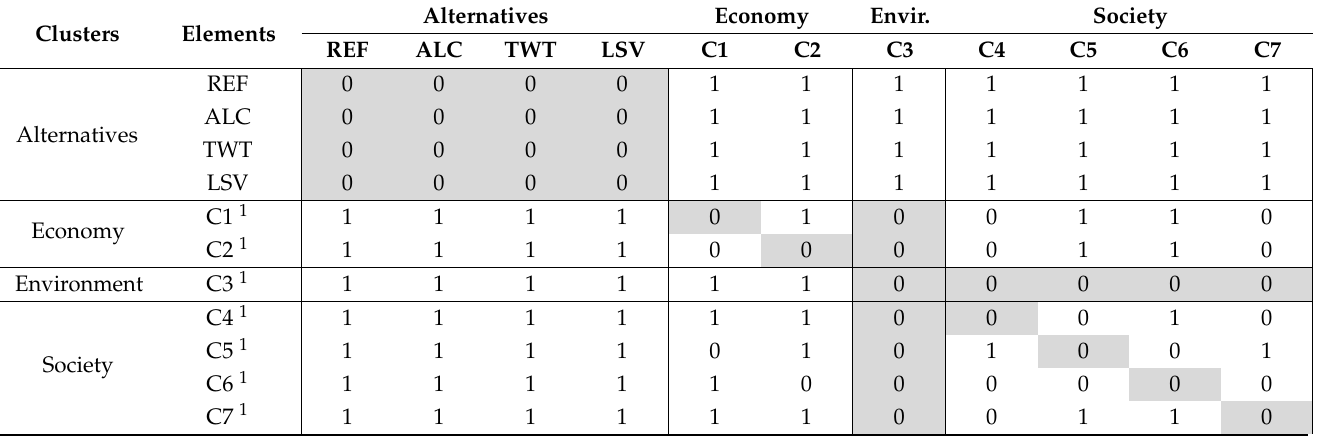
Table 5. Influential supermatrix from DM 1.